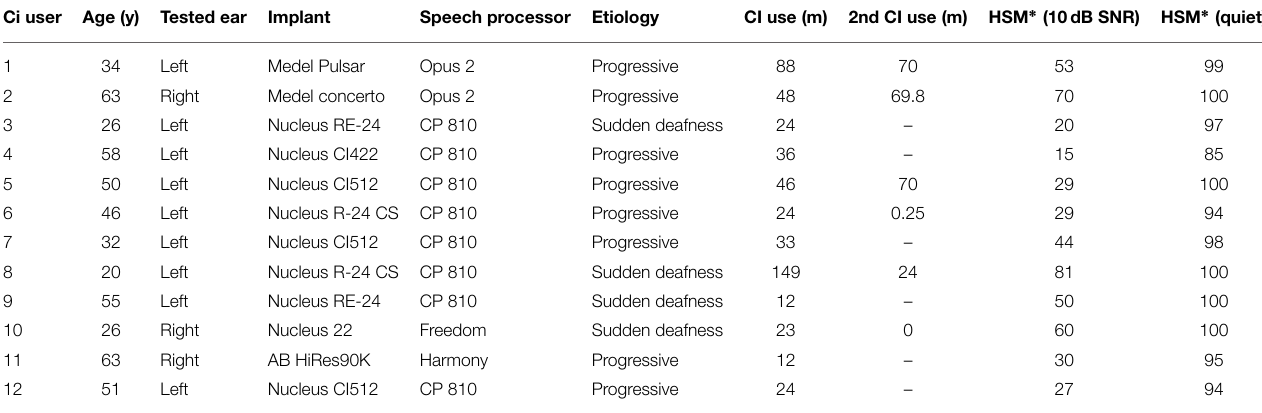
TABLE 1 | Participant demographics of the cochlear implant group. Ci user Age (y) Tested ear